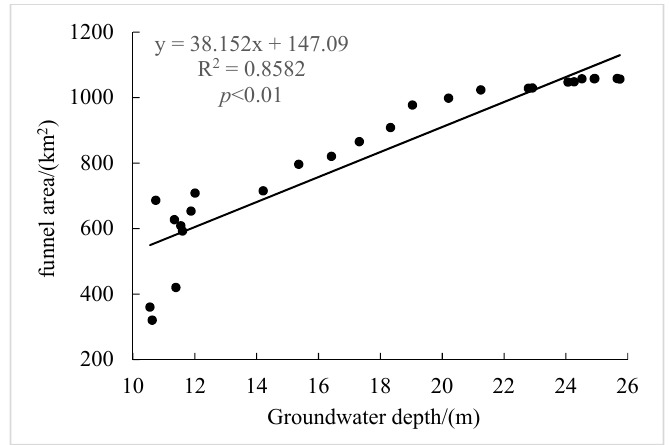
Figure 8. Correlation between groundwater depth and funnel area.